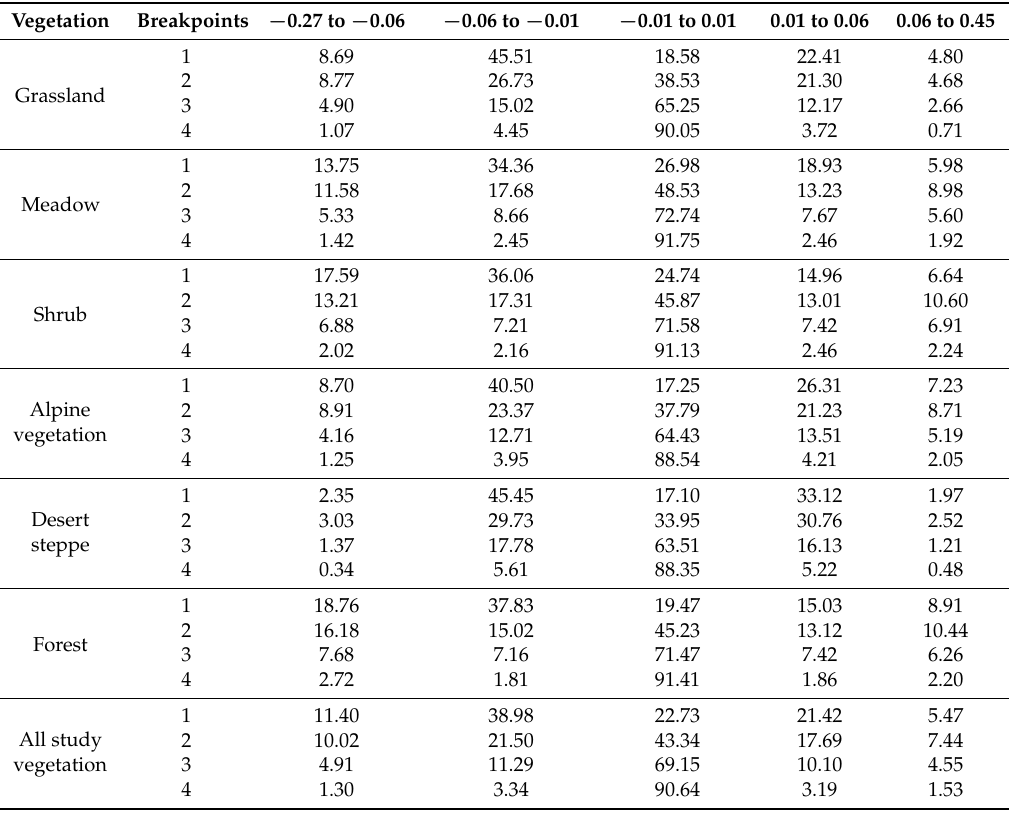
Figure 6. Spatial distributions of the estimated magnitudes of abrupt changes in the trend component in the Qilian Mountains in the period of 2000–2017: ( a ) first breakpoint distribution; ( b ) second breakpoint distribution; ( c ) third breakpoint distribution; and ( d ) fourth breakpoint distribution. Other means no vegetation and managed vegetation areas. Table 3. Statistical results of area percentages for different changes in the magnitude of different vegetation types between 2000 and 2017.